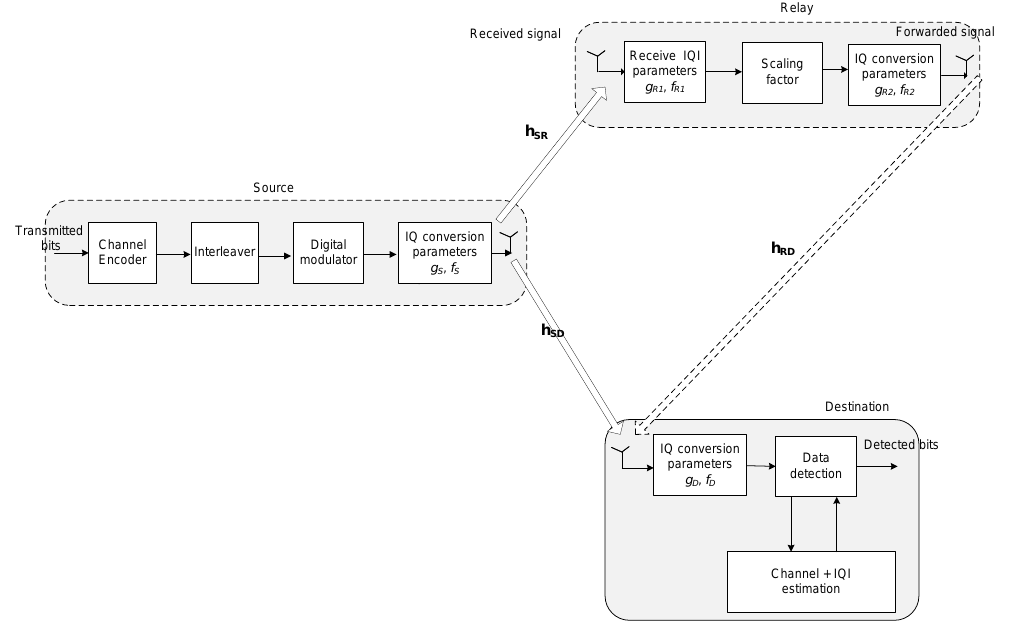
Figure 1. The principal structure of S , R , and D terminals. The solid arrows indicate broadcasts during the first pass and the dashed arrow describes broadcasts during the second